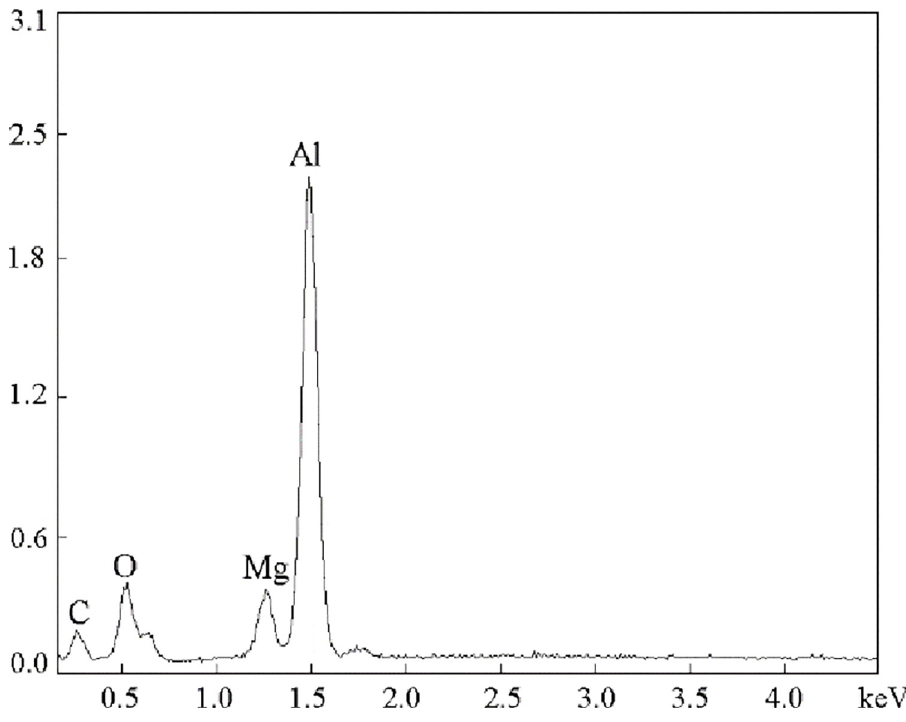
Fig 6. Microstructural energy spectrum analysis of AZ91 alloy after particle refinement.